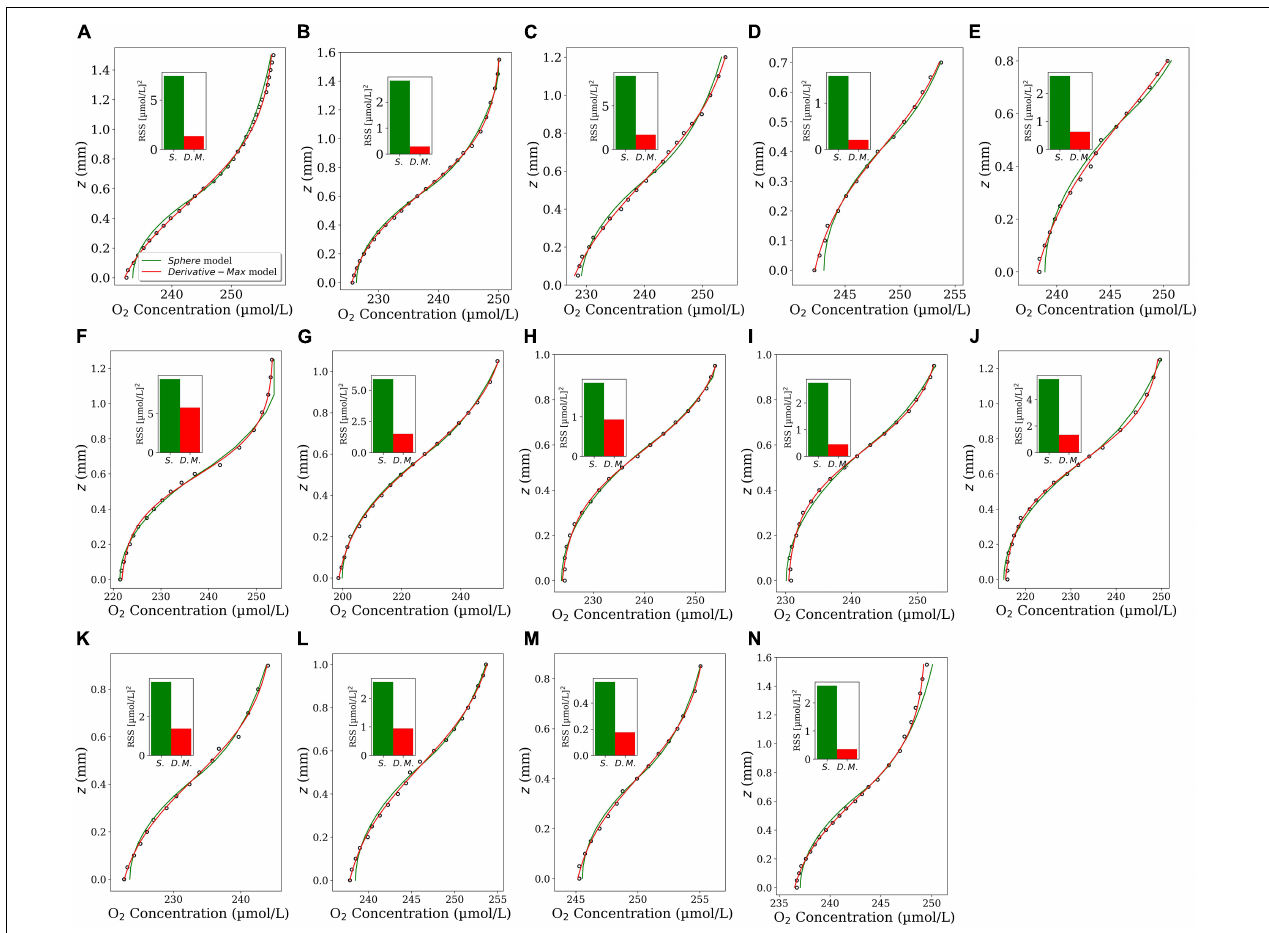
FIGURE 4 | Comparison of the best fit-model functions obtained by using the Sphere (green color) and the Derivative-Max (red color) models applied on all the 14 profiles (A–N) shown in Figure 2 . The inset plots show the residual sum of squares (RSS) for the best fit of each